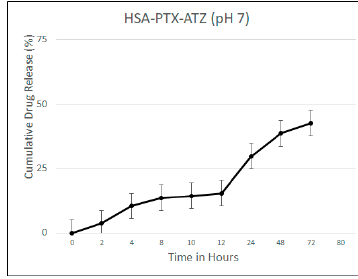
Figure 2. Drug release studies at pH 7 for the hypoxia targeting drug delivery system HSA-PTX-ATZ.